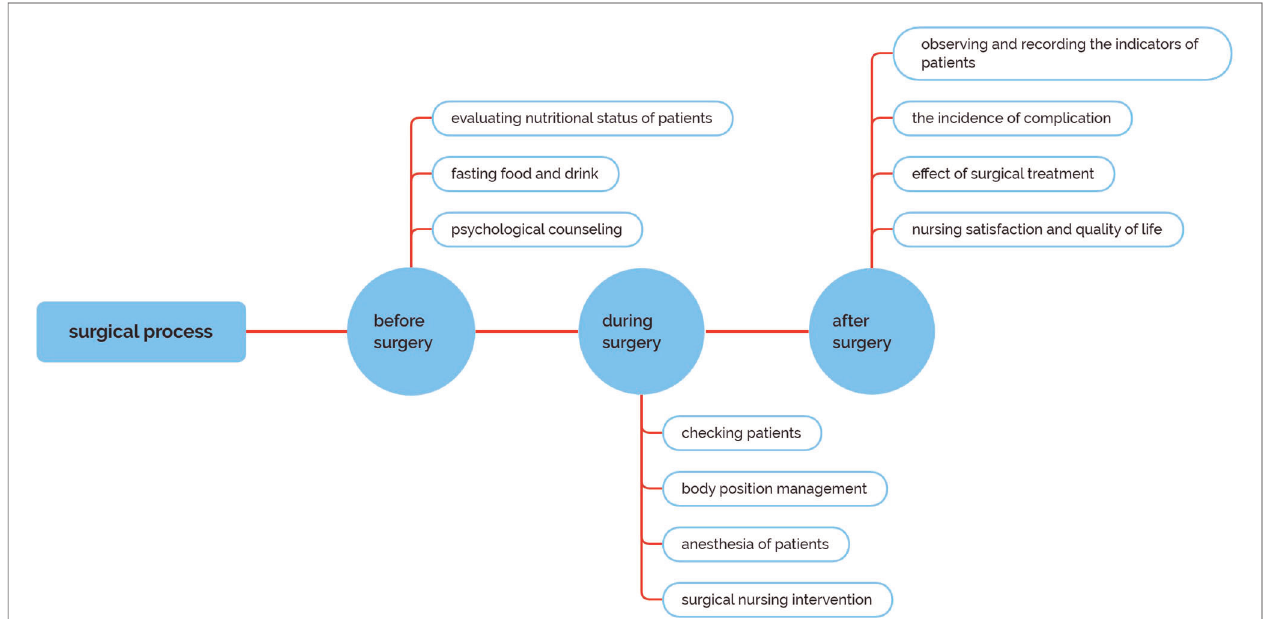
FIGURE 1 | General surgical process during the perioperative